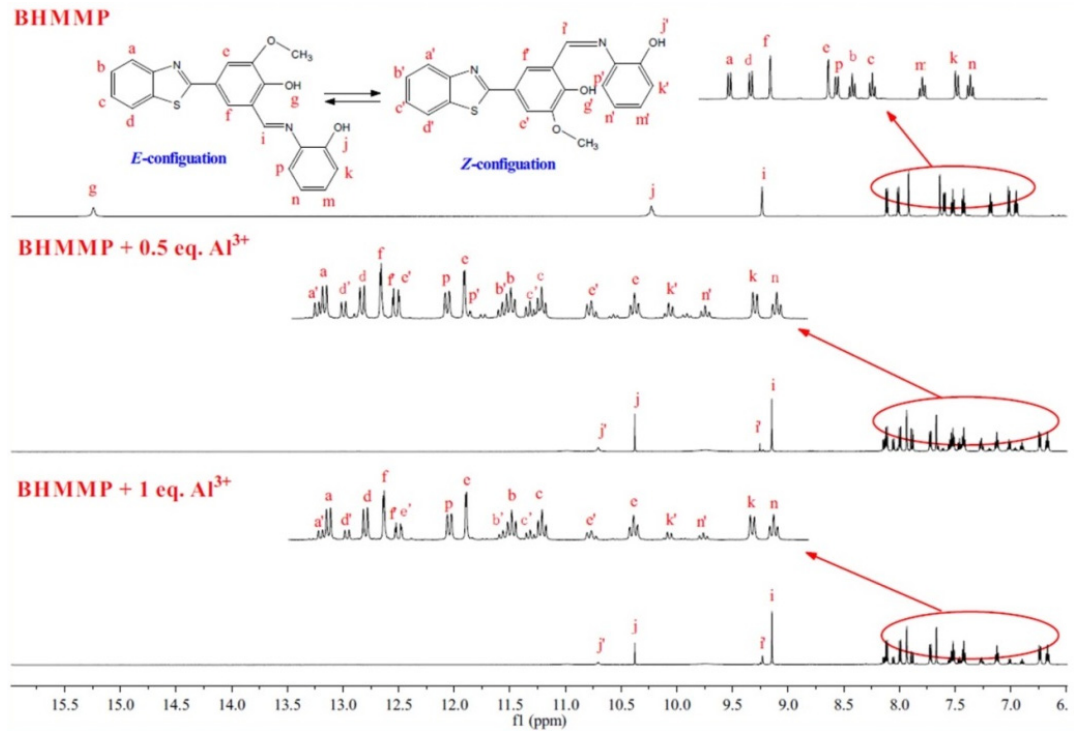
Figure 6. 1 H NMR spectra of BHMMP in the presence of different equivalents of Al 3+ in DMSO- d 6 .